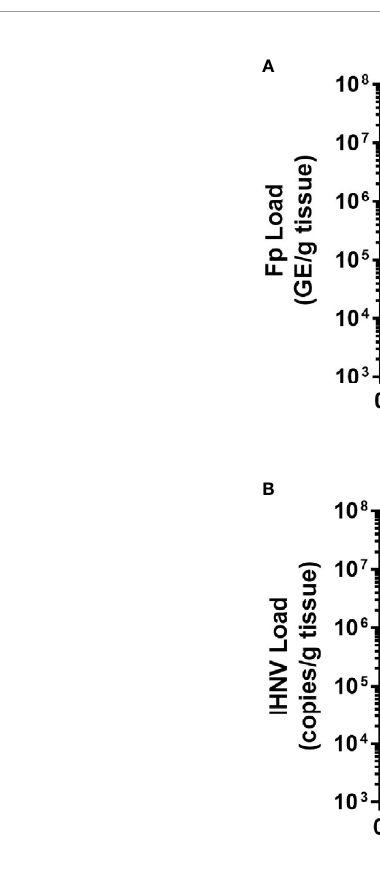
FIGURE 5 | Kinetics of internal pathogen load in fi eld studies. Plots show IHNV (A) and F. psychrophilum (B) load [ A ; Log10 (bacterial DNA copies/g tissue); B : Log10 (viral RNA copies/g tissue or DNA copies)] as well as pathogen prevalence (2nd y-axis, shaded area) in live-sampled, sham-vaccinated Tx-line recipient treatment group fi sh. Individual co-infected fi sh are indicated by solid symbols while singly infected fi sh are indicated by open symbols. N=5 fi sh per time point. Fish with no pathogen detected are not